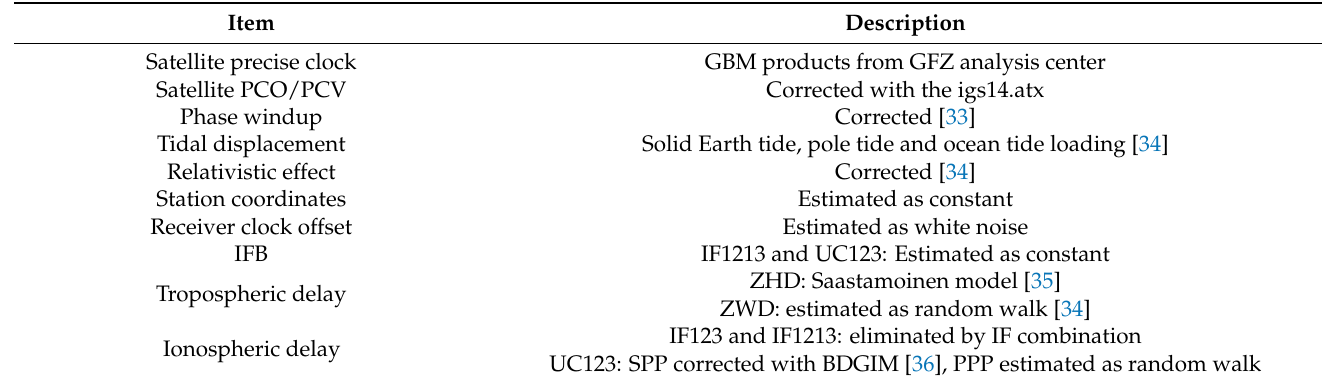
Figure 5. Box plot of IF123 and IF1213 SPP positioning accuracy. The positioning accuracy of all combinations without TGD/DCB correction is poor, with an accuracy of 5~8 m in the horizontal component and approximately 10 m in the vertical component. It is also clear that tgd-corr and dcb-corr positioning accuracy per- form better and have a more concentrated error distribution compared with non-corr. The